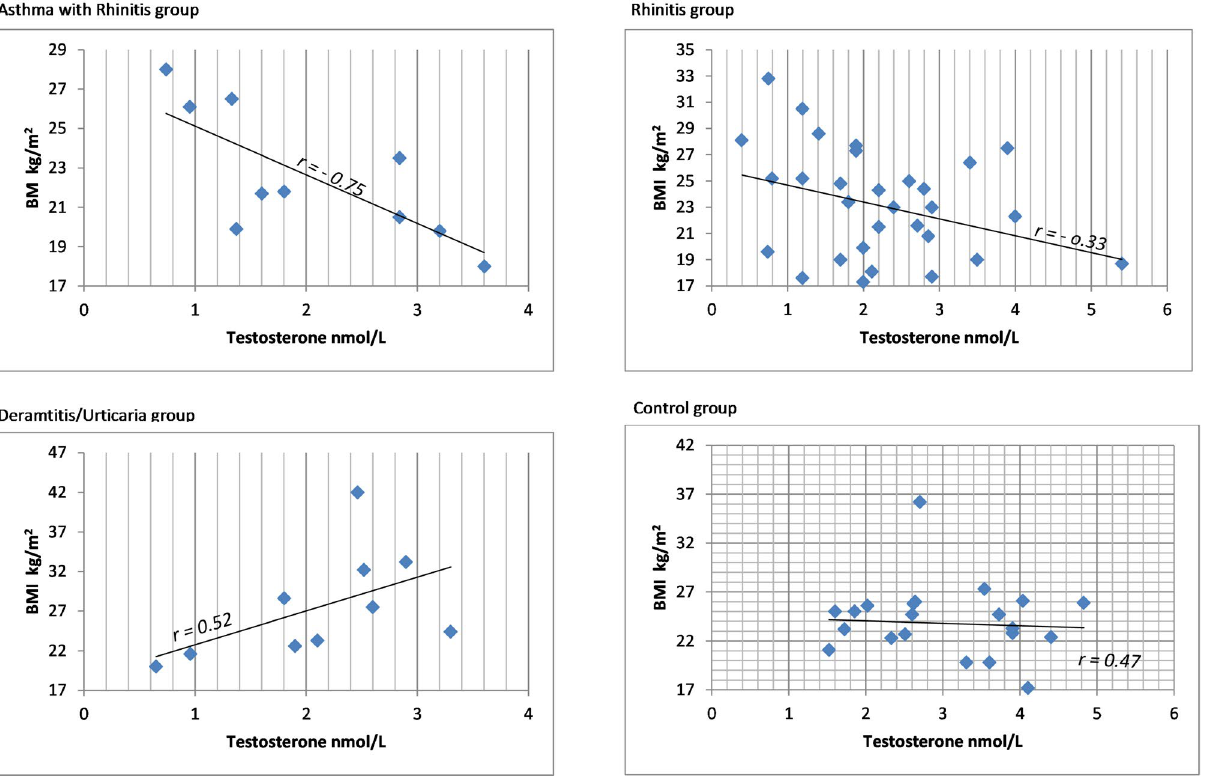
Figure 1. The relation between BMI and serum testosterone levels in females with allergic diseases and controls. A—patients with Asthma; A&R—patients with Asthma and Rhinitis; BMI-body mass index; r —the correlation